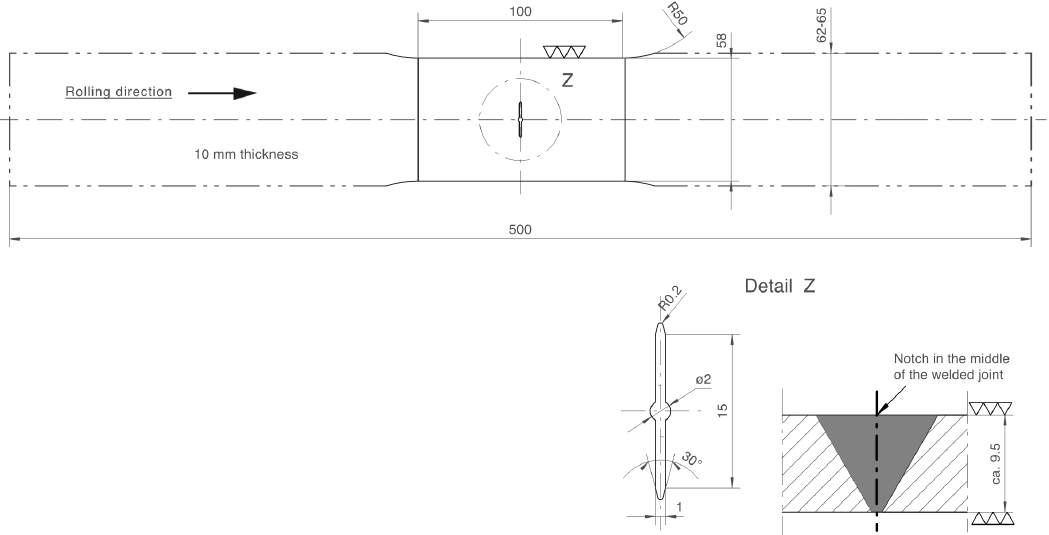
Figure 1. Dimensions of the specimens including magnification of the fatigue crack starter notch centered in the welded joint. In Detail Z ca. 9.5 is representing the approximate thickness of the specimens in milimeters.